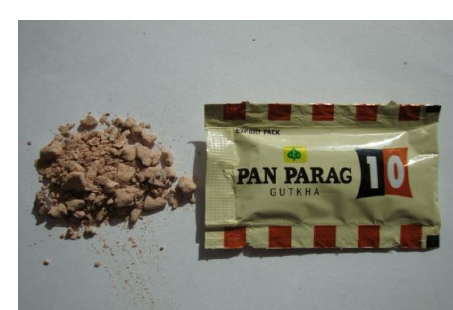
Figure 17. Two types of gutkha